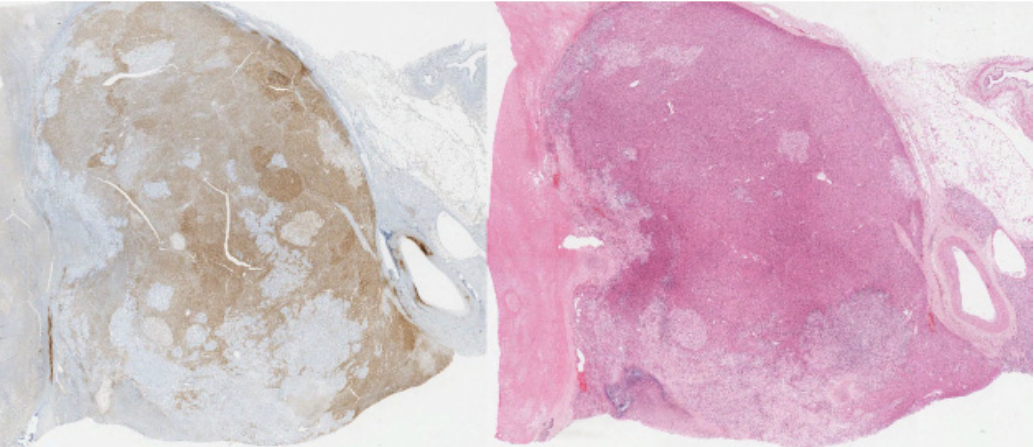
Figure 7. (10x): Synaptophysin stain: cytoplasmic and staining of carcinoma component. IHC for comparison.